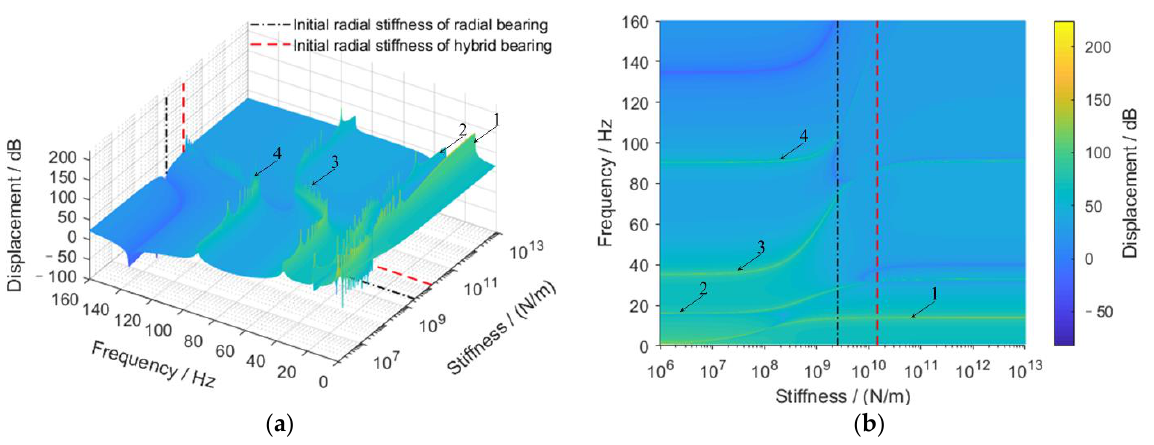
Figure 4. Transverse vibration response under different bearings stiffness and frequency. ( a , b ) are the vibration response at x = 0 m. ( b ) is the top view. Numbers and arrows are used to mark the order of the resonance.